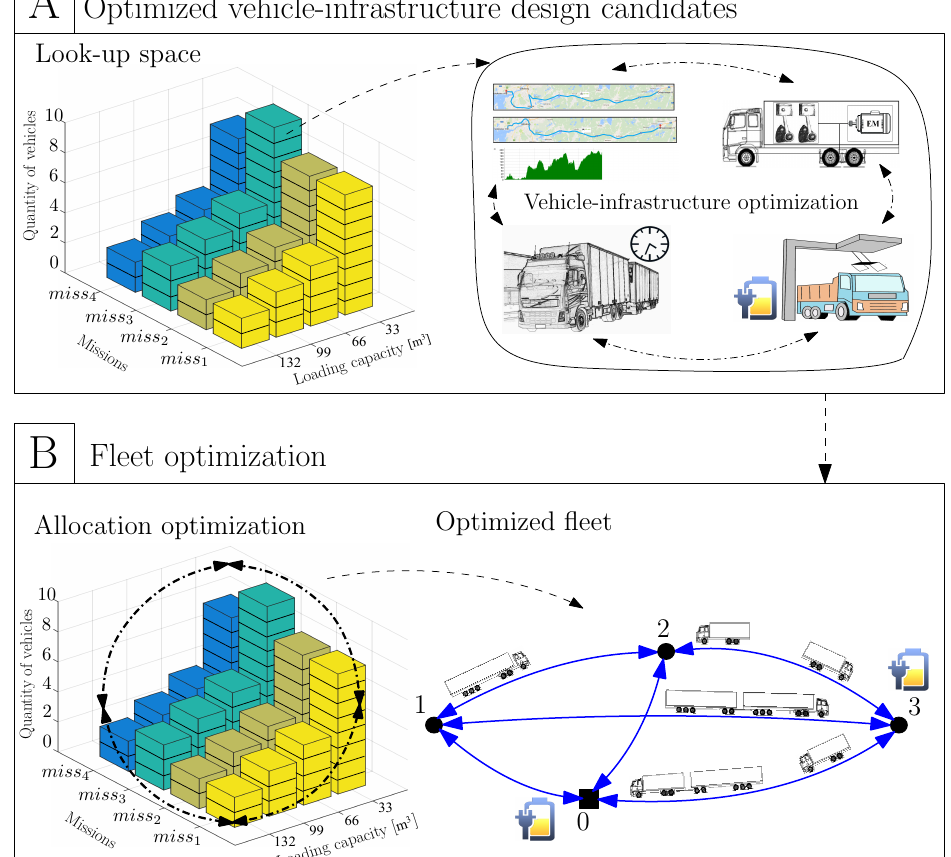
Figure 6. Schematic of algorithm for determining optimum fleet in two stages—( A , B ). Vehicle- infrastructure optimization was repeated for each combination of mission, loading capacity and quantity of vehicle in the look-up